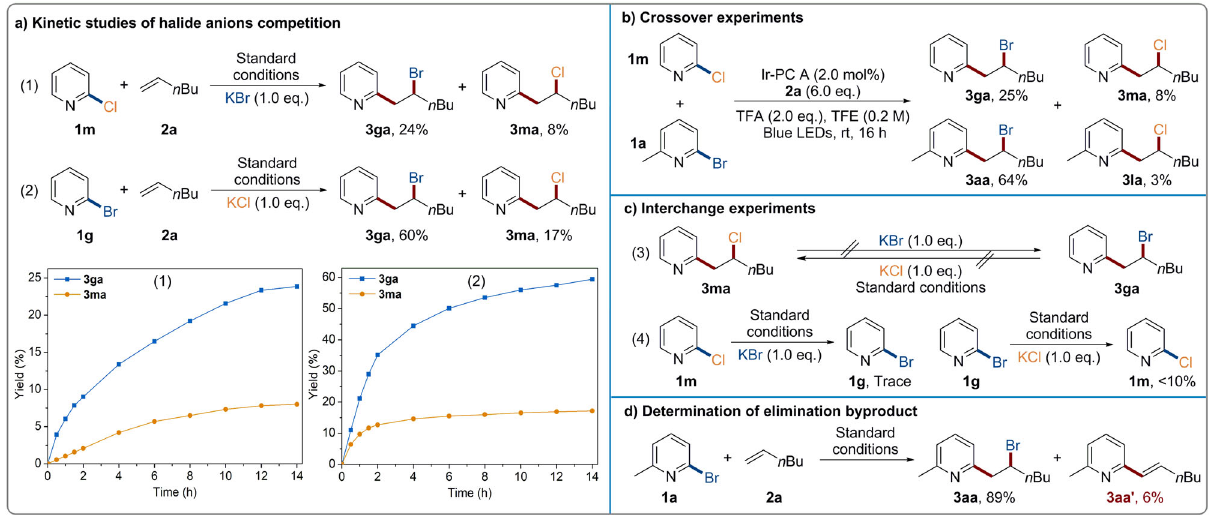
Fig. 4 Halide anions competition experiments. a Kinetic studies of halide anions competition. b Crossover experiments. c Interchange experiments. d Determination of elimination